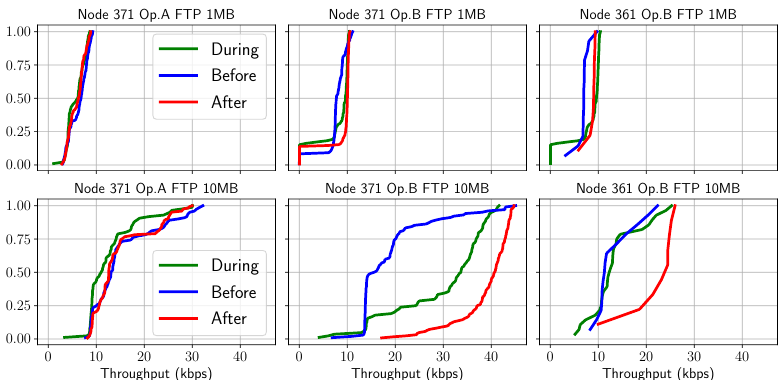
Figure 3. CDF of FTP throughput behavior before/during/after the